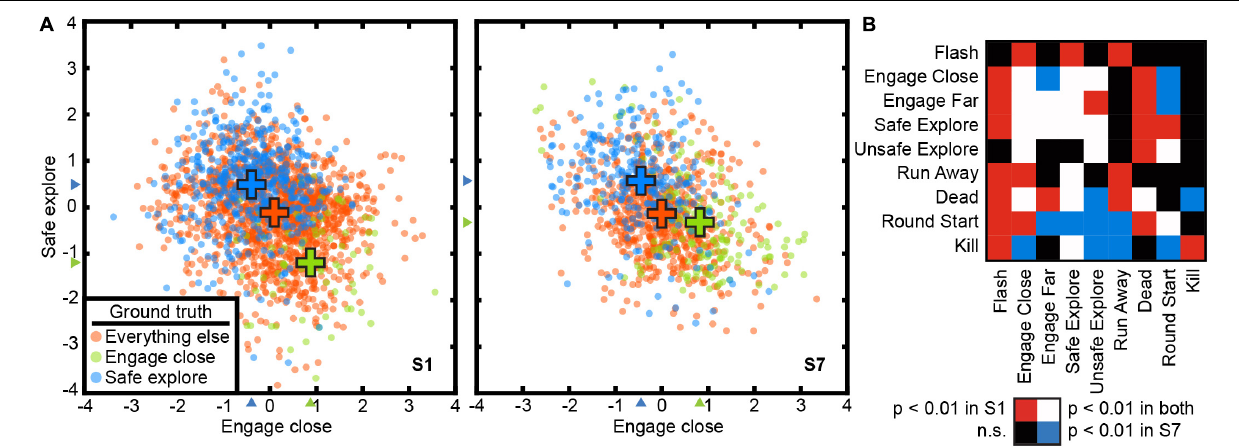
FIGURE 3 | The state space method recovered a task-related state space in the open-ended video game task. Cortical activity at each TR is projected to a point in a 9-dimensional state space. The state space method revealed significant relationships between the nine behavioral states in the video game task. The nine states are not orthogonal, and some states are likely to lead to others. (A) The state space projected to two dimensions for “safe explore” and “engage close” for both subjects. TRs are color-coded by their ground truth state. Blue: safe explore; Green: engage close; Orange: all other states. Crosses indicate the mean positions of each group. The CSI was 0.72 for subject C1 and 0.62 for subject C2, indicating significant separation of the clusters ( p < 1e-5, permutation test). These two states are mutually exclusive and score negatively on each other’s axis. (B) Relationships between states are reflected in non-zero projections of states on to other state dimensions. Rows and columns are behavioral states as described in Table 1 . The table is asymmetric because relationships between states are not necessarily reciprocal. Colors indicate Bonferroni-corrected significance ( p < 0.01, permutation test). Red: significant for subject C1; Blue: significant for subject C2; White: significant in both subjects; Black: not significant in either subject. Because the task is open-ended, subjects may adopt different strategies and thus the exact pattern of correlation differs between subjects. Task variables in a complex, open-ended task are represented in a low-dimensional space in cortical activity that also captures relationships between